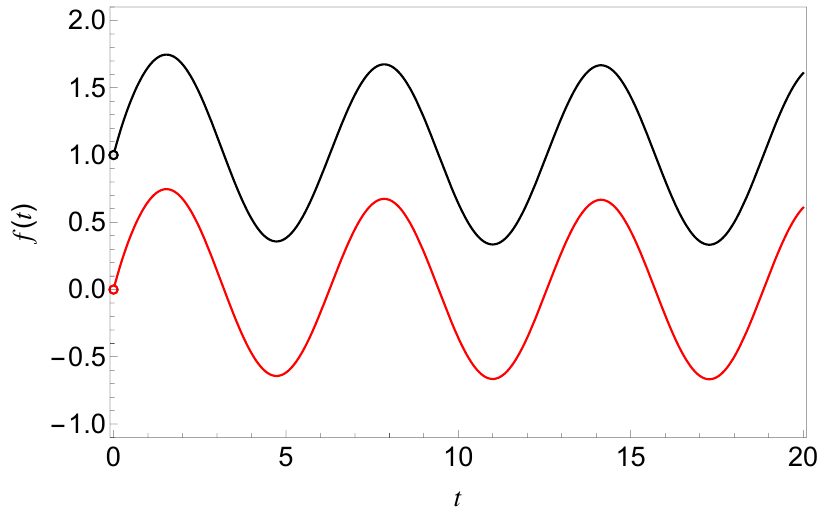
Figure 1. The black and red curves represent the IVP solutions given by Equations (66) and (70) respectively with f 0 = 1. The open circle on each curve indicates that both solutions are valid for t >